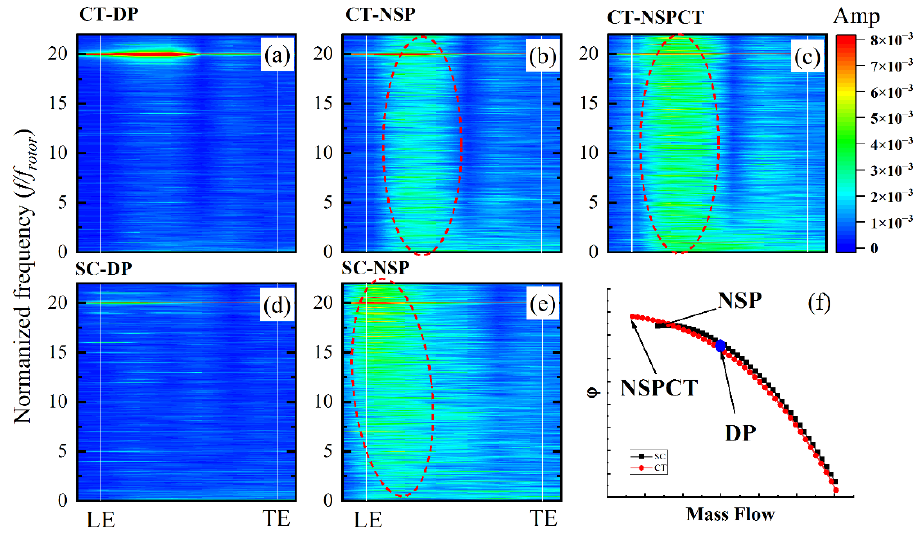
Figure 18. Comparison of frequency spectrum of the compressor, with and without casing treatment. ( a ) frequency spectrum with CT, at DP, ( b ) frequency spectrum with CT, at NSP, ( c ) frequency spectrum with CT, at NSPCT, ( d ) frequency spectrum with SC, at DP, ( e ) frequency spectrum with SC, at NSP, ( f ) pressure rise characteristics of the compressor